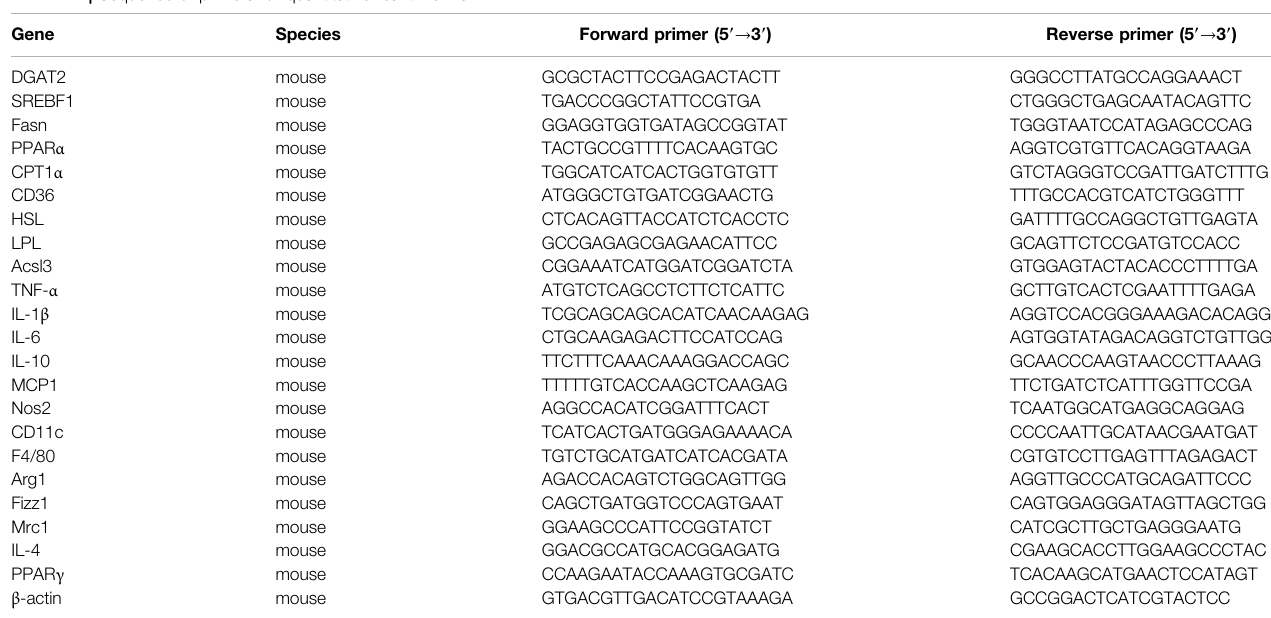
TABLE 1 | Sequence of primers for quantitative real-time PCR Gene